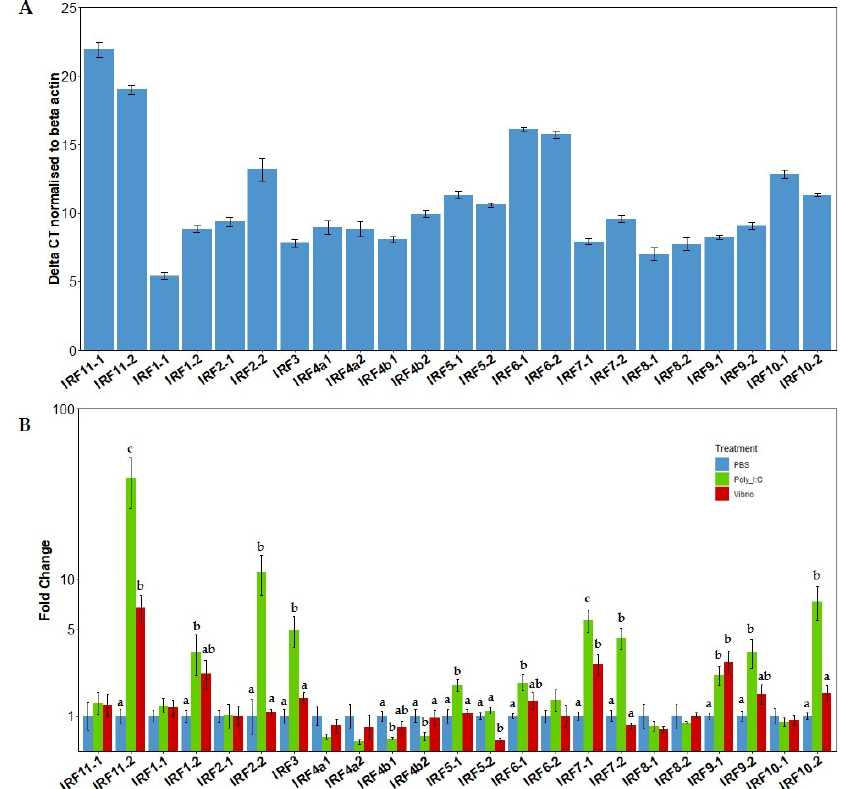
Figure 5. ( A ). Relative constitutive expression of IRFs in control (PBS) fish spleen tissue. Bars represent the delta CT (DCT) of the IRFs when normalised to the house keeping gene β actin ( ± SEM), n = 4. ( B ). Fold change expression of IRF family members in spleen tissue of rainbow trout. Fish were injected i.p. with either PBS, V. anguillarum extract or poly I:C for 24 h. Expression was normalised to the housekeeping gene β actin. A linear model was used for analysis of all genes. Bars represent fold change relative to the PBS control group ( ± SEM), n = 4. Results of the Tukey post hoc test are displayed above the bars. Bars which do not share a letter are significantly different.